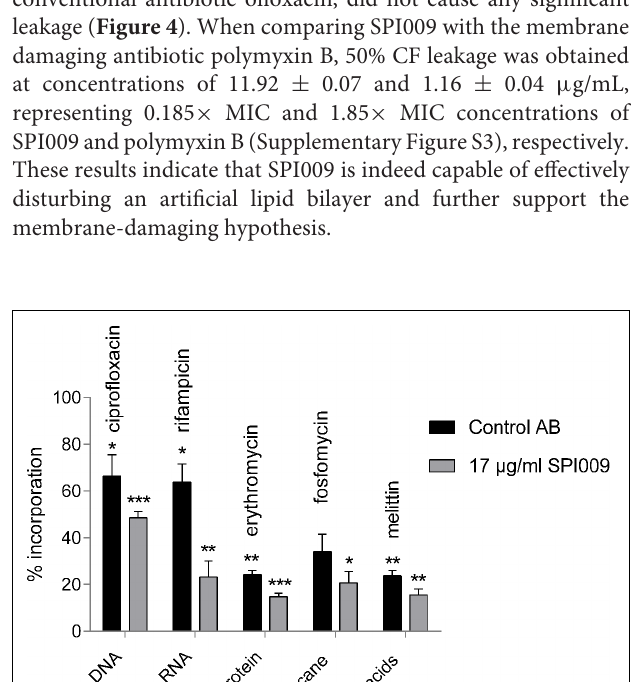
FIGURE 4 | SPI009 causes extensive CF leakage. SUVs were treated for 15 min with increasing concentrations ( x -axis) of SPI009 (open circles) or the inactive analog SPI005 (open squares). Increasing concentrations of ofloxacin, used as a negative control, did not result in any CF leakage (data not shown). % CF leakage was determined by fluorescence measurements, corrected for background fluorescence and expressed relative to the positive control (0.5% Triton X-100). Data points represent the mean of three independent repeats ±